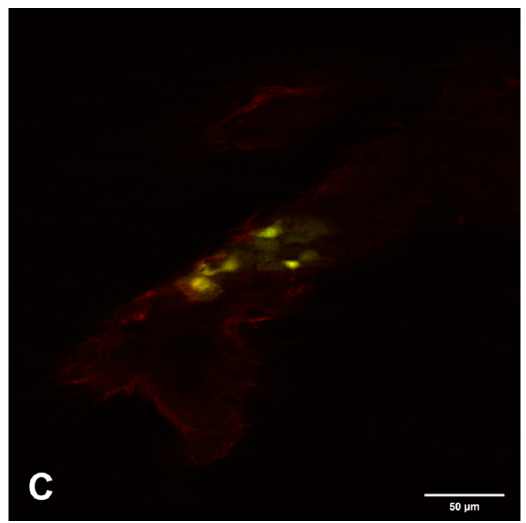
Figure 7. Confocal microscopic analysis of SINV-GFP (green) infection focus and EC specific FMRFamide-TX Red immunoreactivity in the PMG region of mosquito #3 day 7 p.i. ( A ) Single GFP infection focus. ( B ) FMRFamide positive ECs. ( C ) Merged image of ( A , B ) demonstrating the yellow color observed when SINV and EC colocalize. 200×.